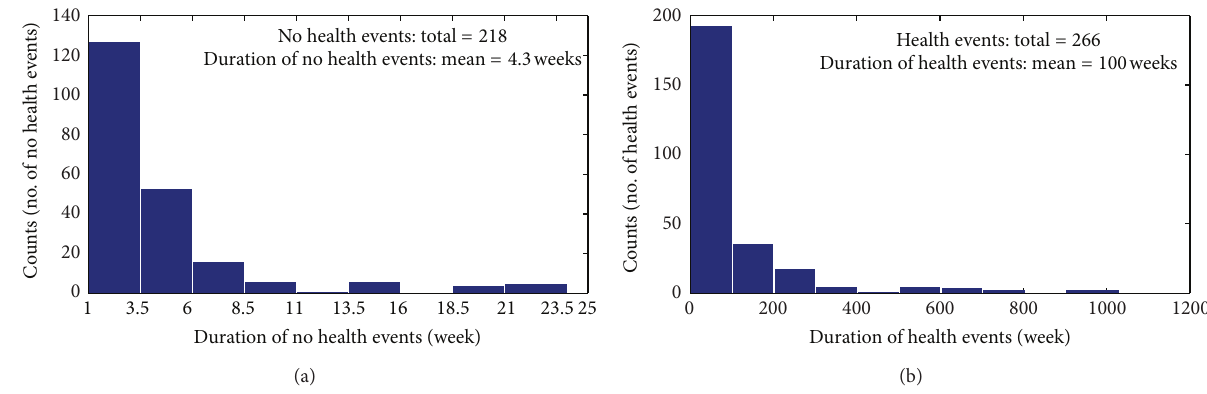
Figure 4: Histograms of the time duration of relapses and remissions for the 70 selected patients. (a) Histogram of no health events (+1 states); (b) histogram of health events ( − 1 states). Both figures show exponential decaying distributions with no sign of periodicity (i.e., peak at given duration), suggesting that disease events occur randomly in time. To be noted is the different duration of relapses and remissions (on average 4.3 weeks against about 100 weeks).